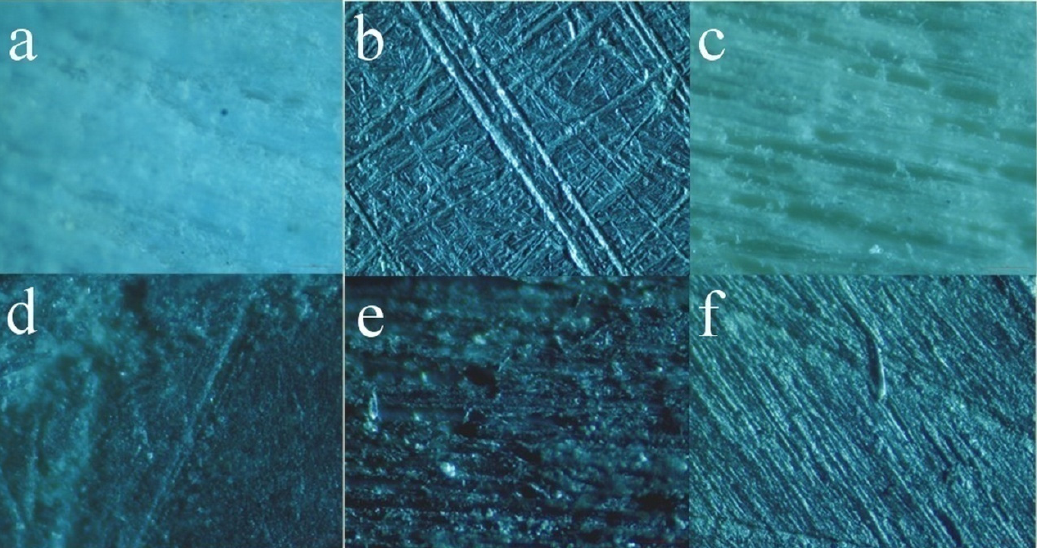
Figure 3. Fluorescence image of nano-Al metallized wood (( a ) original wood, ( b ) Al target, ( c ) sputtering Al 20 s, ( d ) sputtering Al 50 s, ( e ) sputtering Al 15 min, ( f ) sputtering Al 60 min).